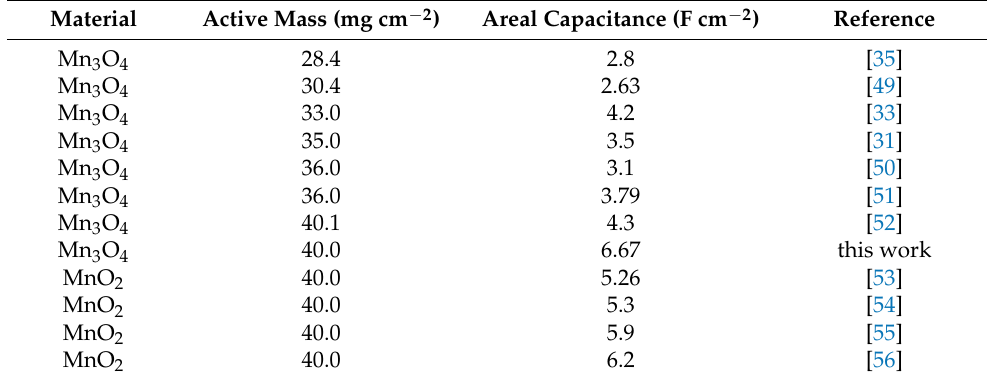
Table 1. Literature data on capacitances of Mn 3 O 4 - and MnO 2 -based electrodes containing conductive additives and tested in Na 2 SO 4 electrolyte.